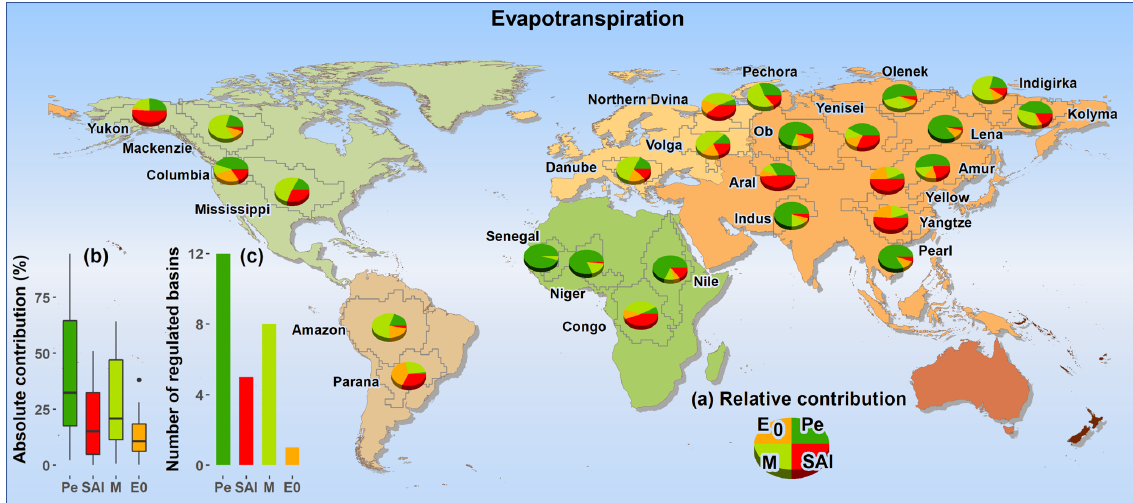
Figure 9. The same as Fig. 8 but for relative contribution to the changes in